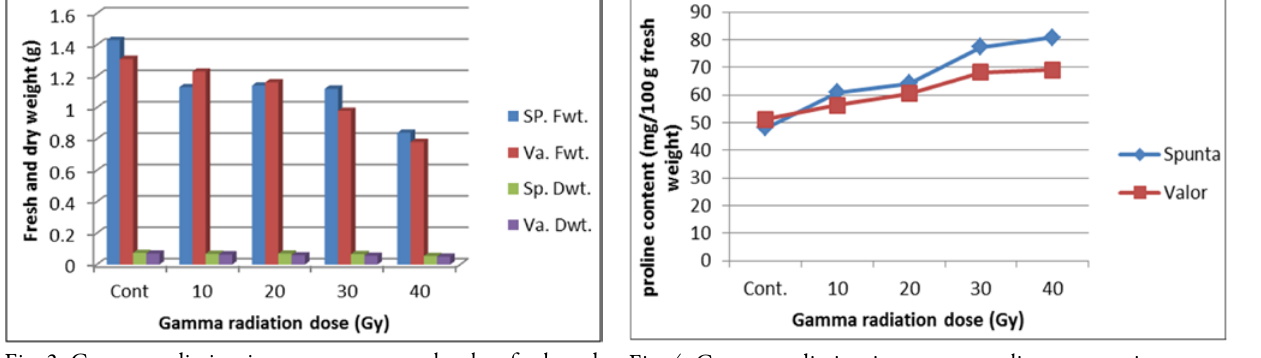
Fig. 4. Gamma radiation impact on proline content in potato plantlets cvs. ‘Spunta’ and